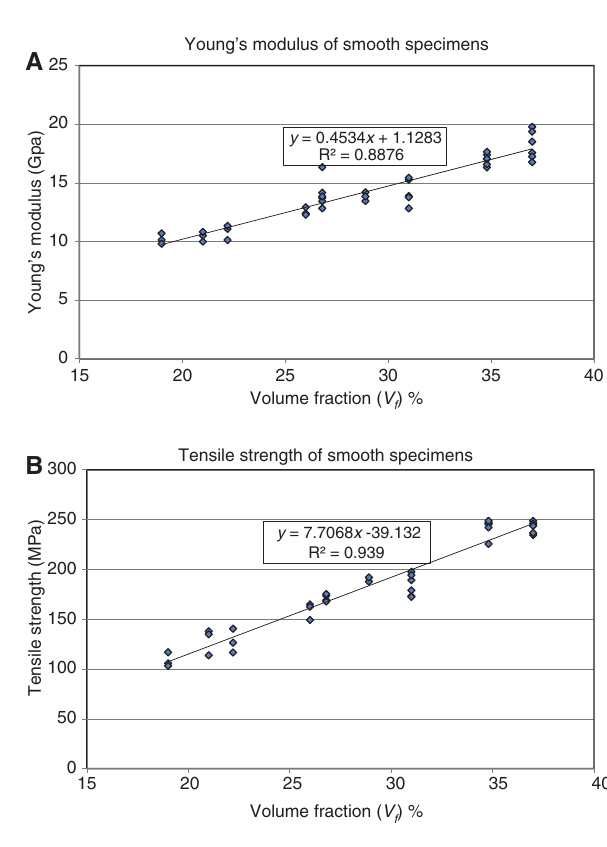
Figure 3 Tensile test result of smooth specimens.